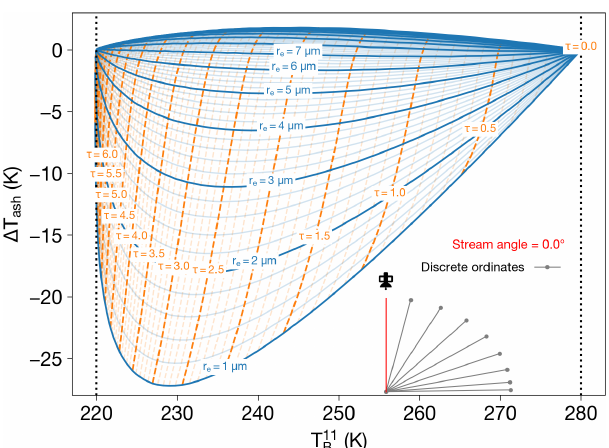
Figure A3. Graphical illustration of a volcanic ash look-up table for a surface temperature T s = 280K and cloud-top temperature T c = 220K. Dashed near-vertical lines indicate lines of constant op- tical depth, τ , and solid U-shaped curves indicate lines of constant effective radius, r e